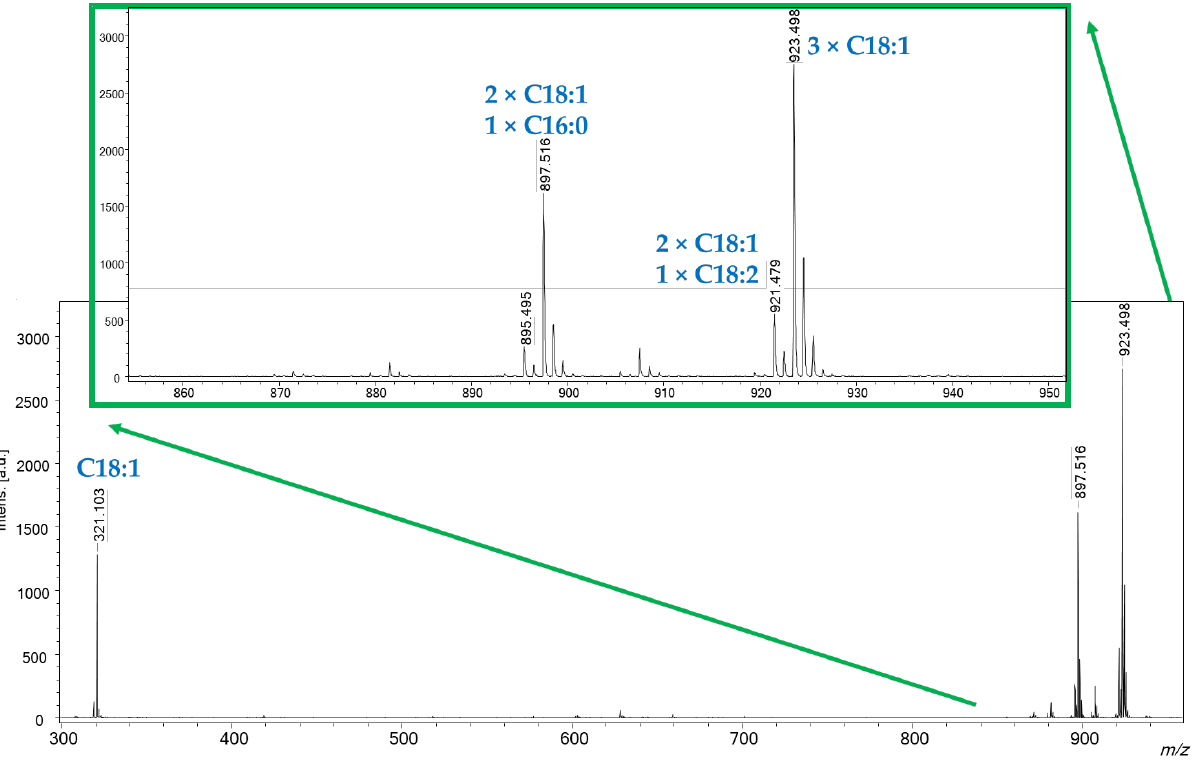
Figure 8. SALDI-MS spectrum of an olive oil sample, dilutes 1:1000 with dichloromethane. Identification of detected species was confirmed by MS/MS analysis.